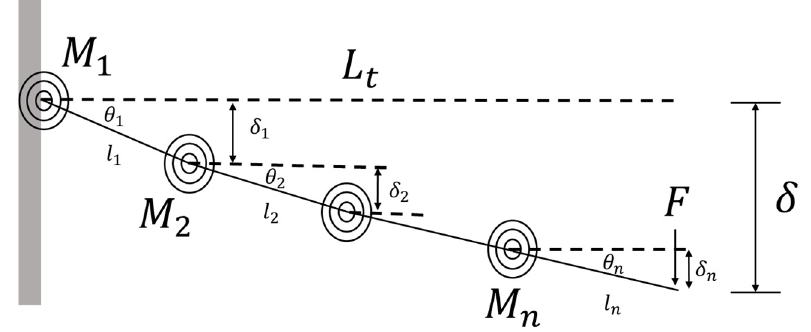
Figure 12. Flexible multi-body modeling method for the power cable structure.